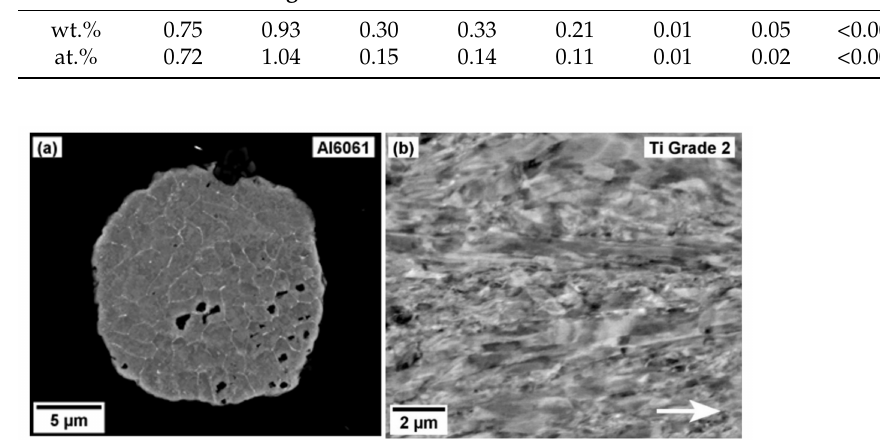
Table 1. The chemical composition of Al6061 alloy according to the supplier. Element